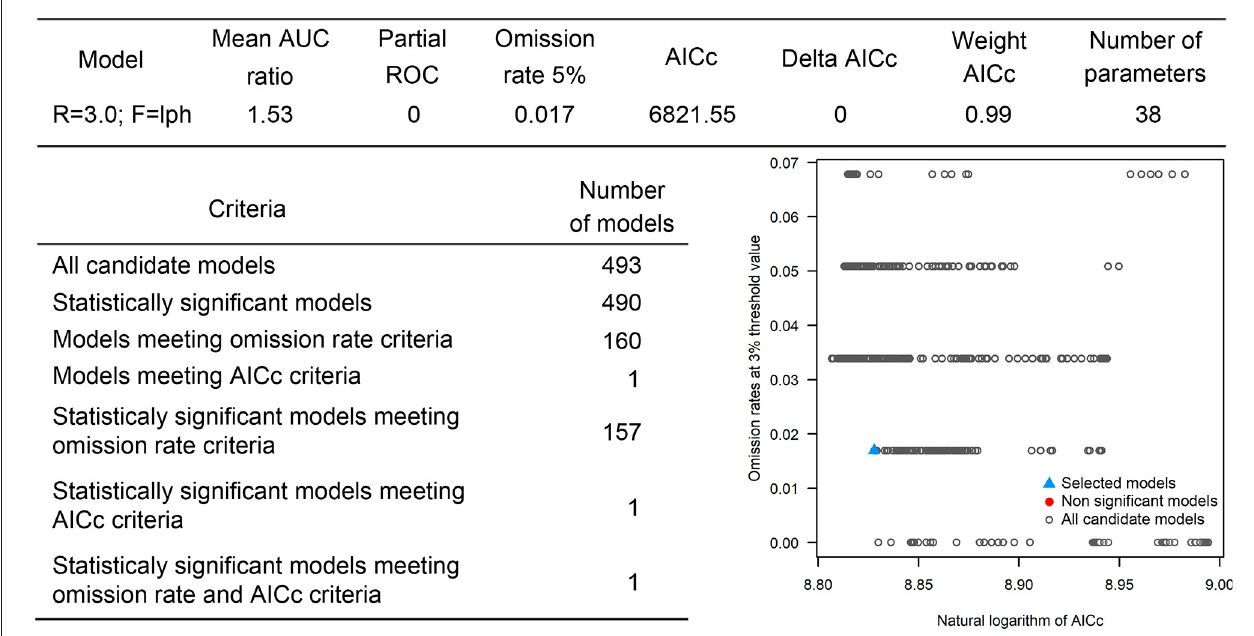
FIGURE 4 | Model calibration statistics for hosts.